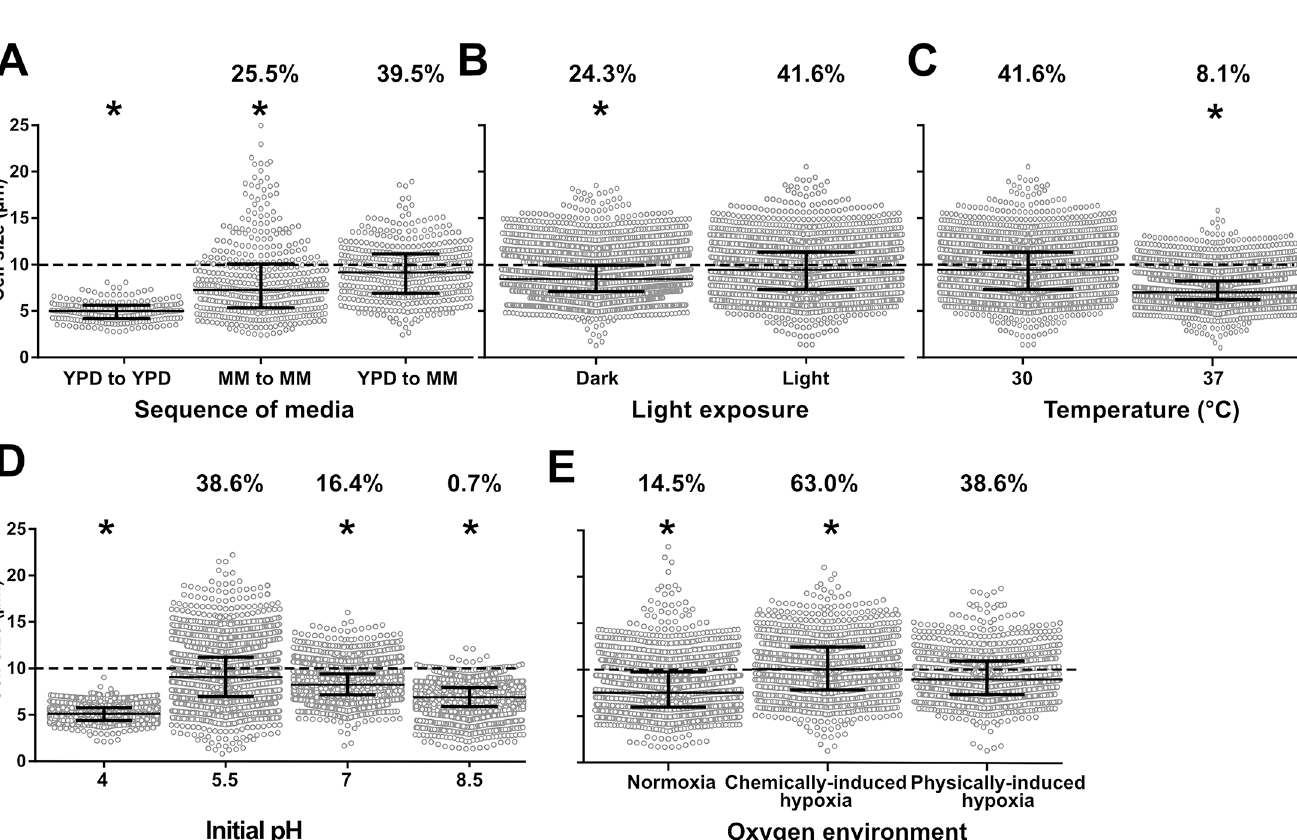
Fig 4. Titan cells generation in vitro is impacted by various environmental conditions. ( A ) The sequence of media used at steps 2 and 3 of the protocol was crucial for titan cells generation: yeasts cultured in Yeast Peptone Dextrose (YPD) and transferred to minimal medium (MM) produced significantly more titan cells (cells > 10μm, dotted grey line) than yeasts cultured in MM or YPD and transferred in MM or YPD, respectively; ( B ) Exposure to d light at step 3 had a positive impact on titan cells generation compared to incubation in the dark; ( C ) Raising the incubation temperature to 37˚C at step 3 decreased titan cells formation compared to 30˚C; ( D ) Modification of the initial pH of the MM used at step 3 impacted titan cells formation with pH 5.5 being optimal while a more acidic (pH = 4), a neutral (pH = 7) or an alkaline (pH = 8.5) pH inhibited titan cells formation; ( E ) The impact of hypoxia was tested by physical (closed cap) and by chemical (COCl 2 in MM at 1 nM) method and compared to normoxia (21% oxygen). Physically- and chemically-induced hypoxia enhances the production of titan cells compared to normoxia with a higher proportion of titan cells in chemically- compared to physically-induced hypoxia. All experiments were performed in triplicate and pooled (mean cell counted ± SD = 2305±1438). Median and IQR are shown in black for each condition ( (cid:3) p < 0.0001 vs reference condition). The percentages above each condition represents the % of titan cells observed.